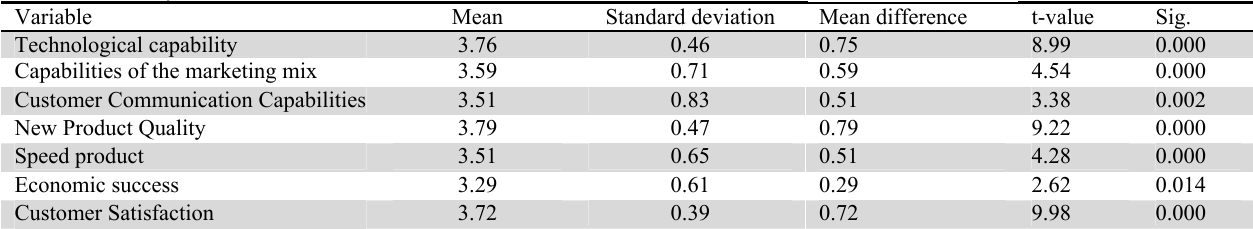
The summary of some basic statistics